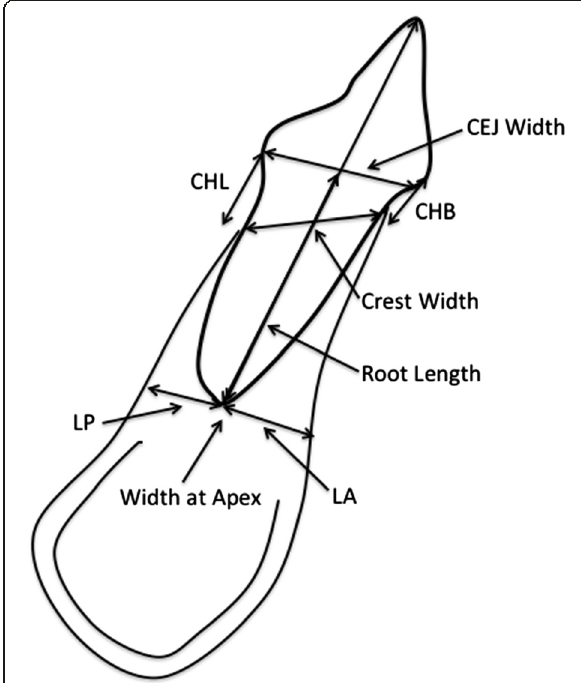
Fig. 2 Schematic of measurements taken through the sagittal view of the tooth and mandibular alveolar bone. CHB crestal height buccal, measured from the CEJ to the buccal crestal bone, CHL crestal height lingual, measured from the CEJ to the lingual crestal bone, LA lower anterior bone thickness at the apex, LP lower posterior bone thickness at the apex, crest width the width of the alveolar bone from the buccal crestal bone to the lingual crestal bone, CEJ width the width of the CEJ, root length measured from the incisal tip to the apex of the root, width at apex width of the alveolar bone at the apex of the tooth, perpendicular to the long axis of the